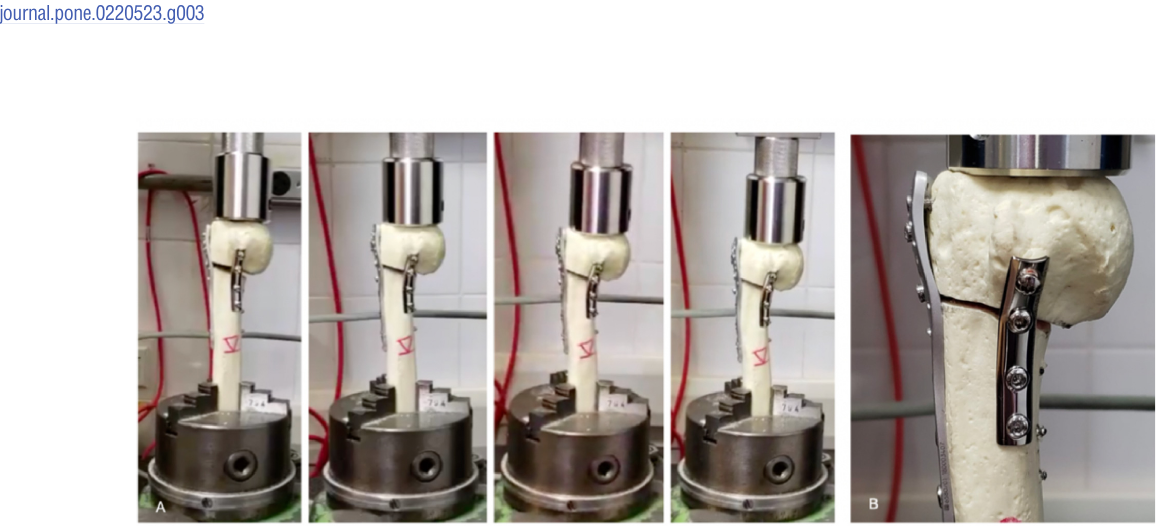
PLOS ONE | https://doi.org/10.1371/journal.pone.0220523 July 30,